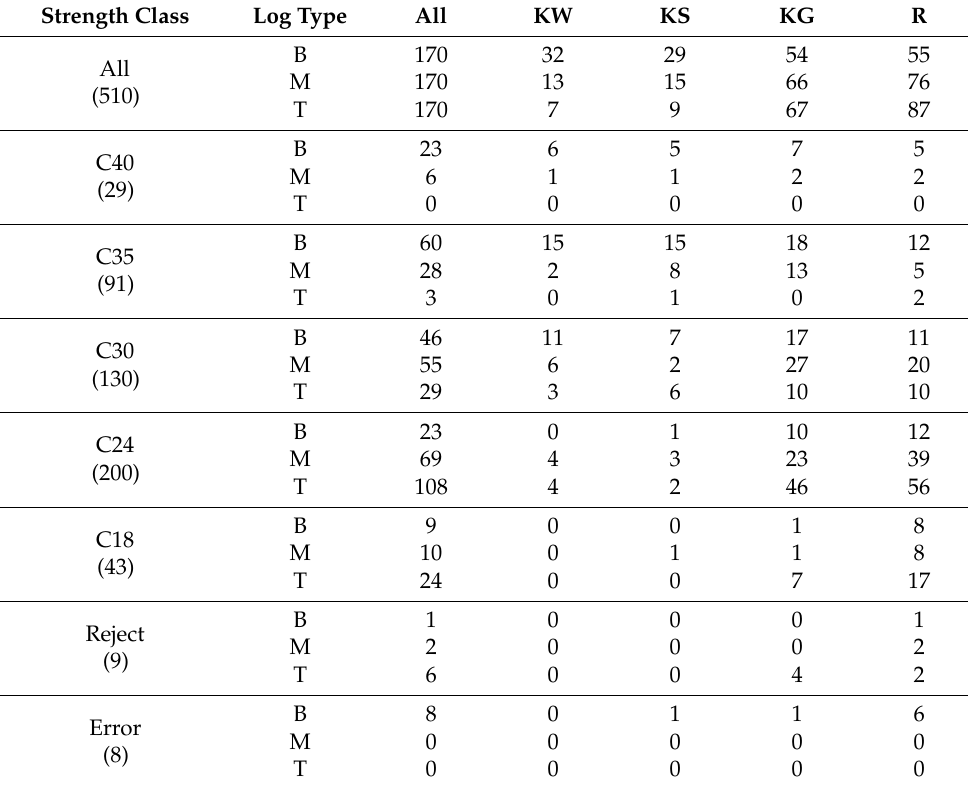
Table 1. Number of timber pieces classified in each class according to